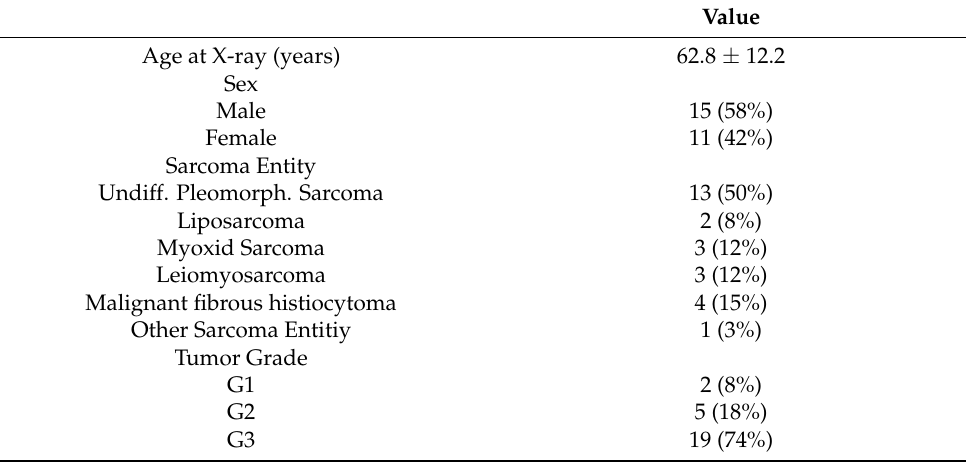
Table 1. Study population of patients with lung metastasis of a soft tissue sarcoma with concordant CT-scan and Chest X-ray ( n =